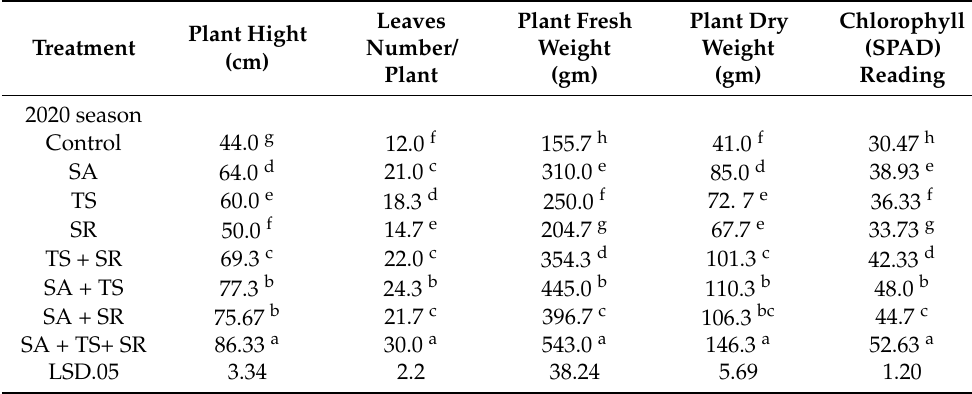
Table 5. Effect of seed priming with 40 ppm shikimic acid (SA) and foliar applications of bioagents on the vegetative growth characteristics of squash plants during the 2020 and 2021